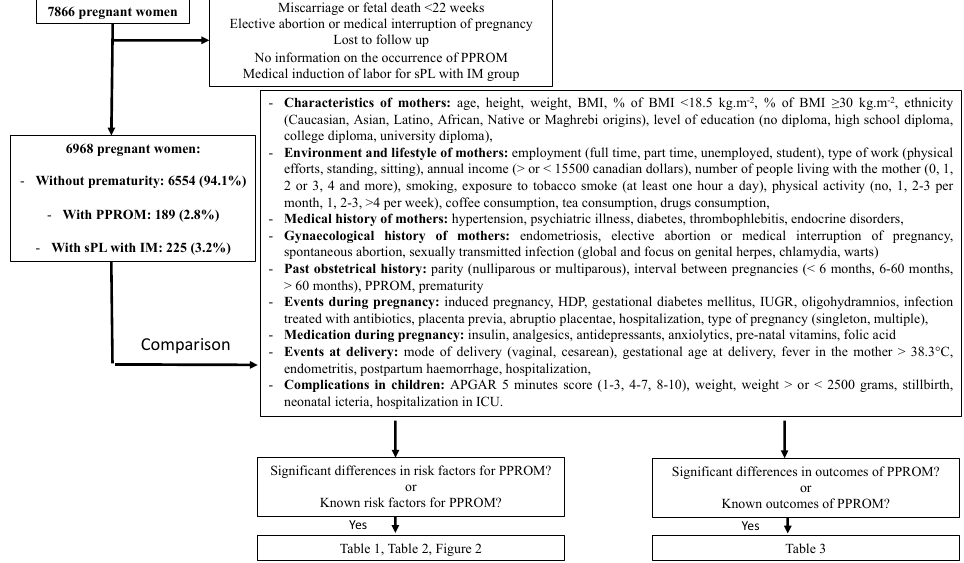
Figure 1. Flowchart of the study. BMI: Body mass index, HDP: Hypertensive disorders of pregnancy, ICU: Intensive care unit, IUGR: Intrauterine growth retardation, PPROM: Preterm premature rupture of membranes, sPL with IM: spontaneous preterm labor with intact membranes.